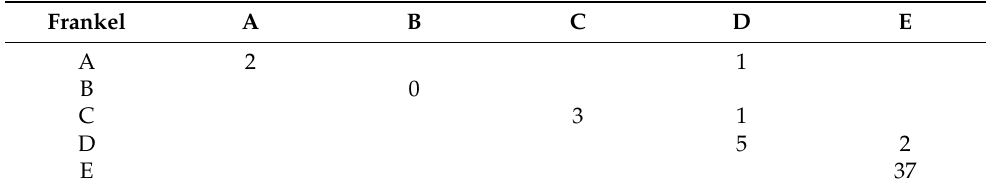
Table 4. Improvement of paralysis by Frankel’s classification before and after